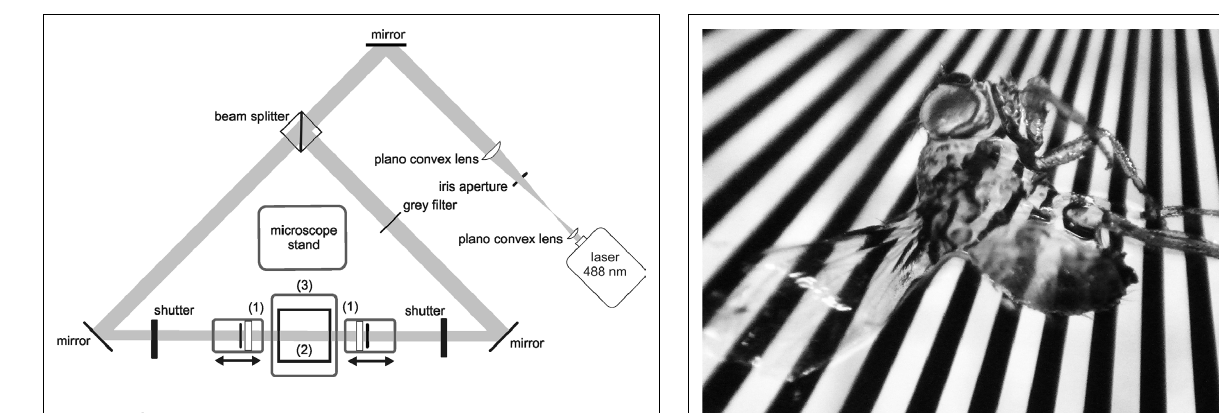
FIGURE 1 | Standard confi guration of an ultramicroscopy setup. A laser beam is expanded and homogenized by two convex lenses and then split into two separate light pathways. Both beams are focussed by cylindrical lenses and slit apertures (1), forming a thin light sheet. The light sheet illuminates the specimen placed in a transparent specimen chamber (2) fi lled with clearing solution. Hence, fl uorescence is only exhibited in those parts of the specimen, which are in the focal plane. The fl uorescence image is projected to a camera target using a microscope objective, and the excitation light is blocked by a matched optical band pass fi lter. By stepping the specimen chamber vertically through the light sheet using a computer controlled jack (3), a stack of optical slices is generated.